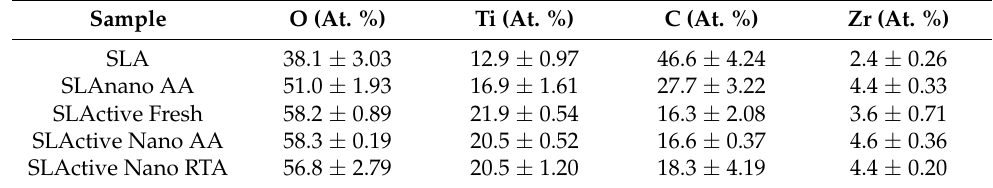
Table 2. Apparent normalized atomic concentration of detected elements as measured by